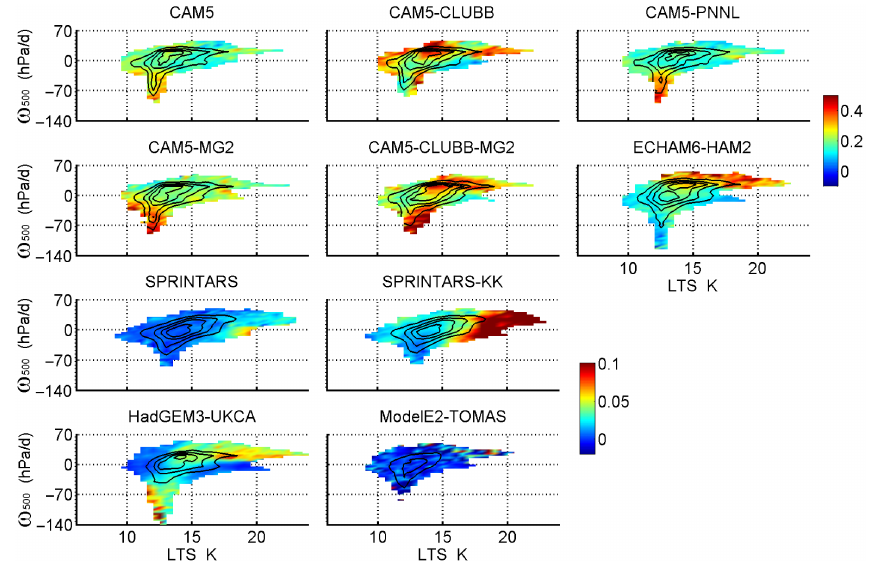
Figure 5. dlnLWP / dlnCCN conditioned on vertical motion and LTS derived from the 10 GCM simulations. Solid lines are contours of grid number distribution and each line interval is 20% of the total counted data.